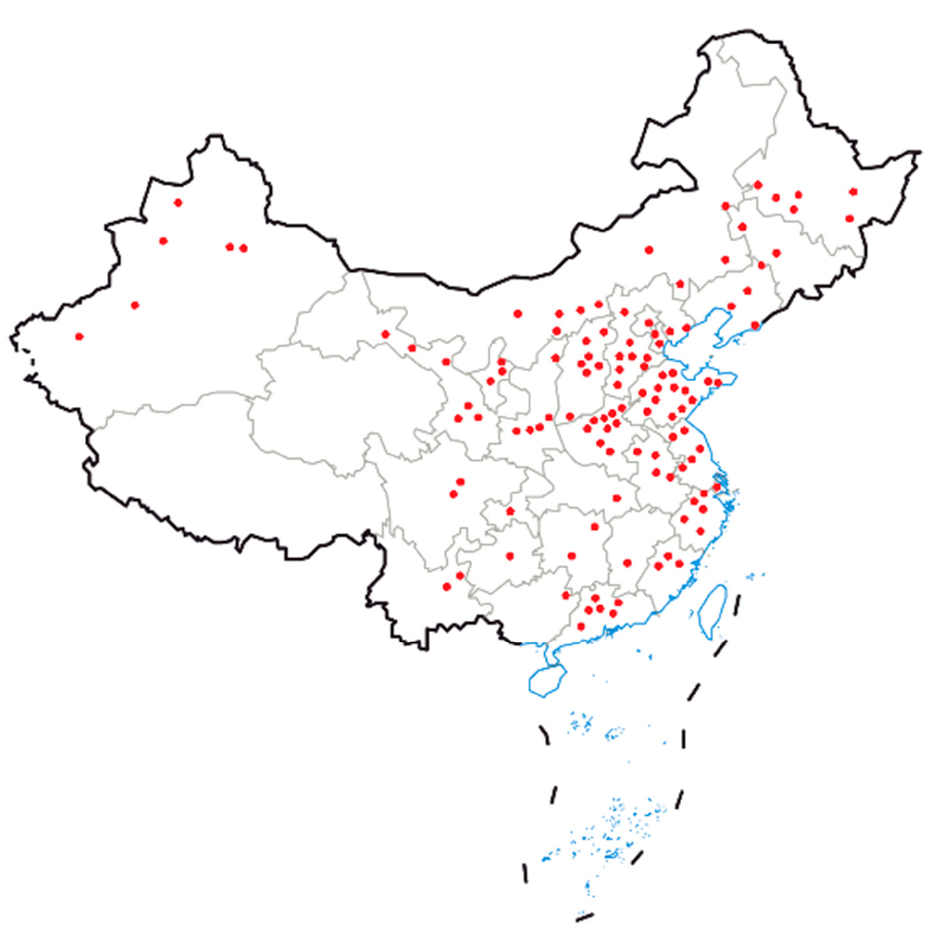
Figure 1. Geographical distribution of the responding dairy farms across China. Each red dot represents a city containing at least one responding dairy farm.